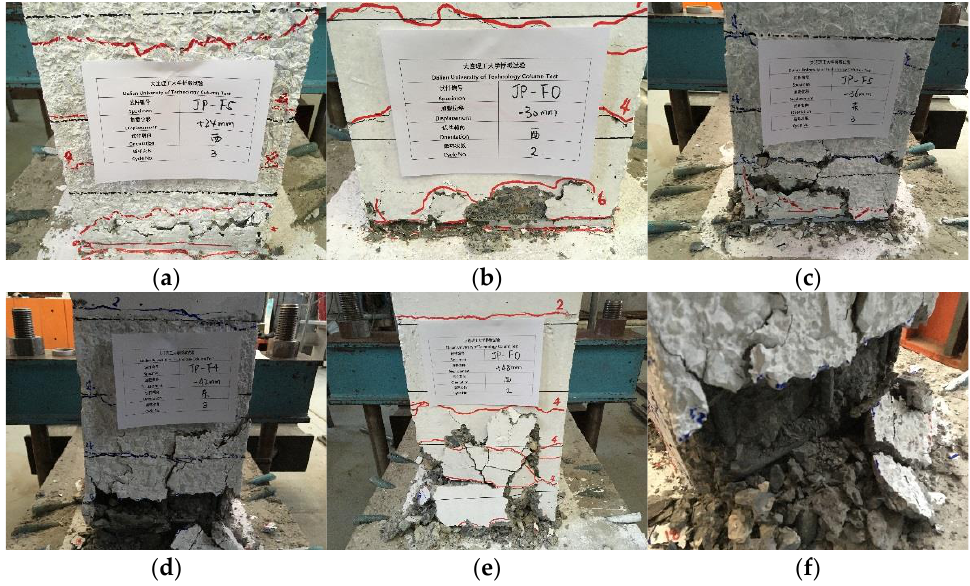
Figure 18. The spalling phenomenon of low cyclic loading test. ( a ) JP-F5(+24). ( b ) JP-F0( − 30). ( c ) JP-F5( − 36). ( d ) JP-F5( − 42). ( e ) JP-F0(+48). ( f ) JP-F5( − 48).